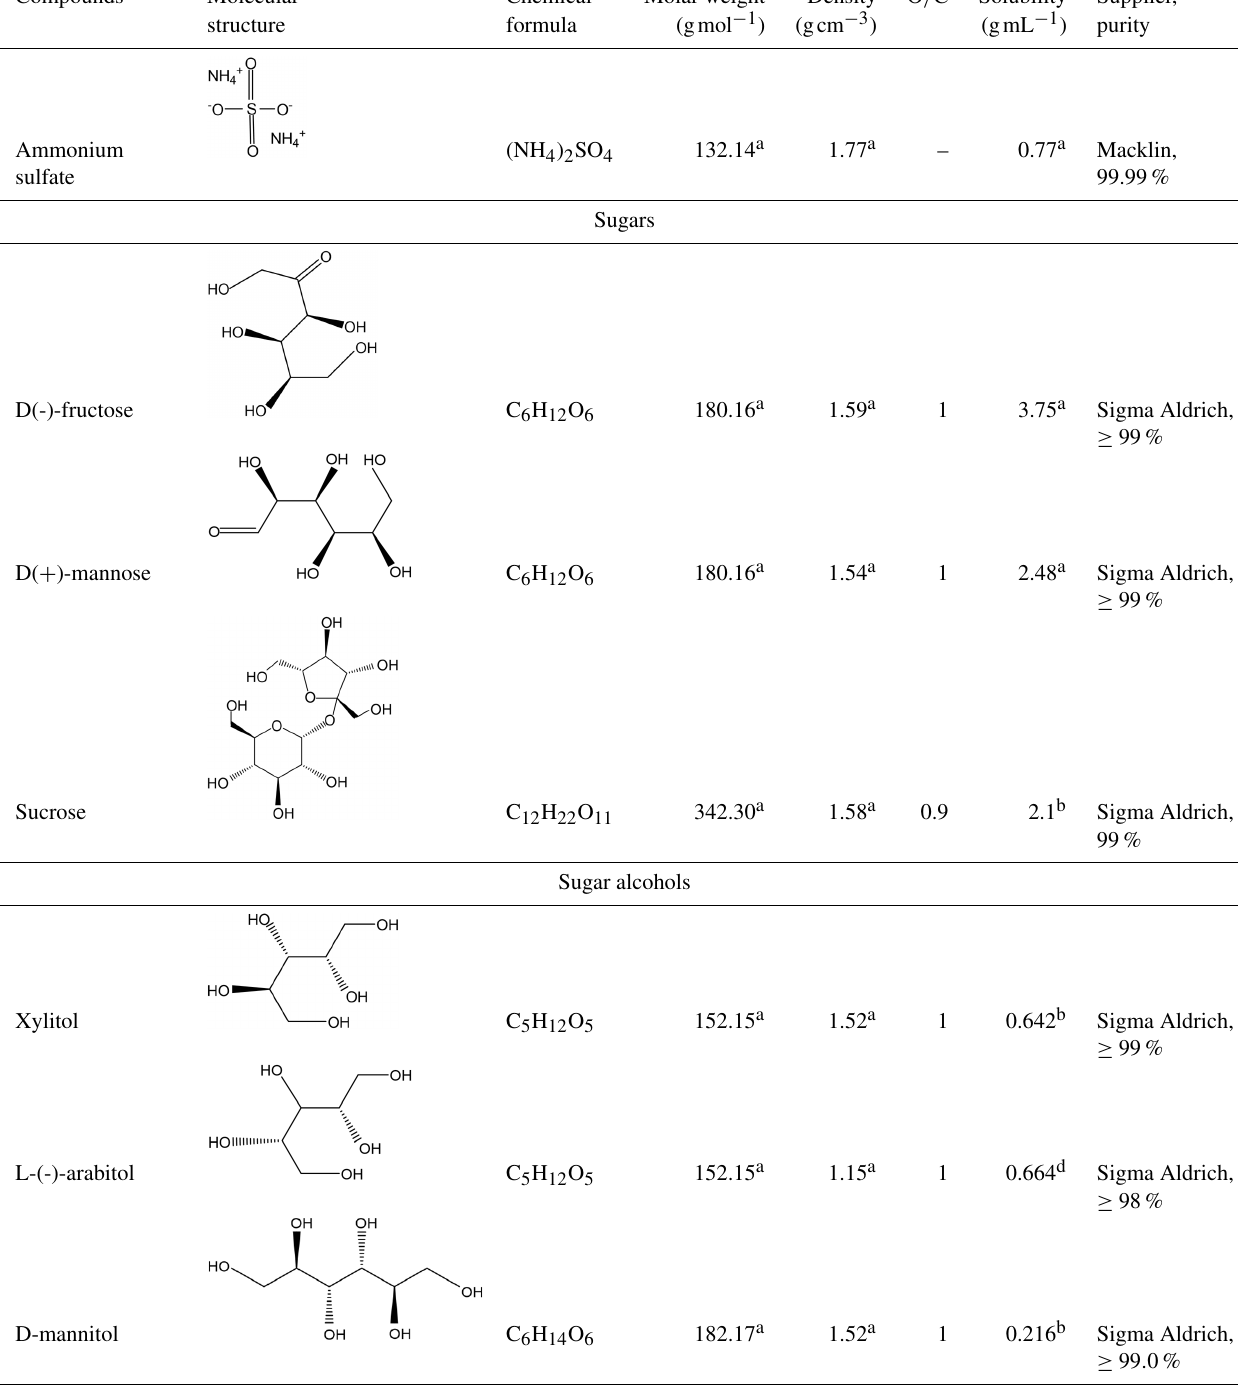
Table 1. Substances and their relevant properties investigated in this study.